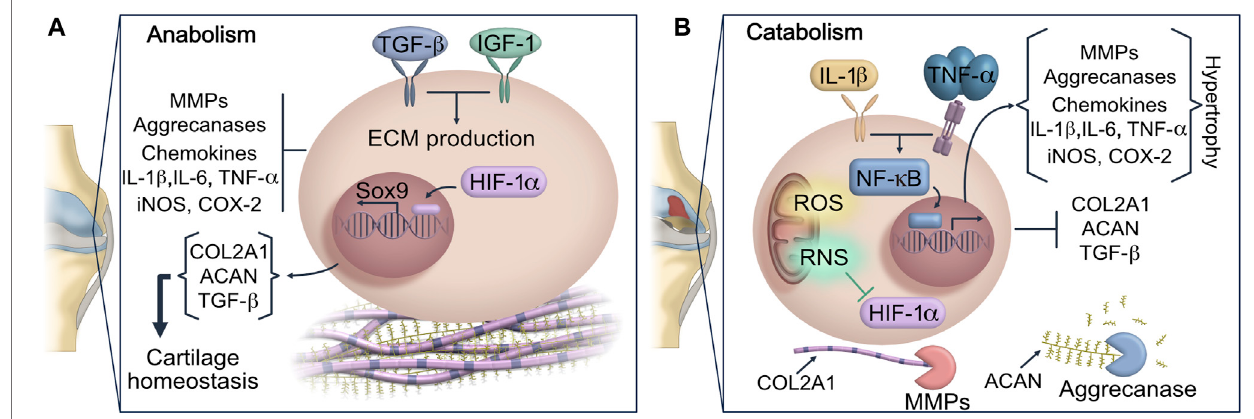
FIGURE 1 | Dysregulation of joint homeostasis in OA. (A) Anabolic metabolism regulates gene expression and protein synthesis of COL2A1 and ACAN in chondrocytes, maintaining components of AC in a low-turnover state. (B) This scheme represents the homeostatic disruption of AC promoted by oxidative stress and pro-in fl ammatory cytokines. IL-1 and TNF- α signaling trigger the upregulation of MMPs and ADAMTS. Then the exacerbated release of MMP-13 prompts COL2A1 and ACAN hydrolysis, which are considered key components of AC matrix. The matrix degradation is intensi fi ed by the activity of ADAMTS, resulting in the loss of cartilage integrity and additional loss of joint function. In fl ammation, ROS and RNS not only stimulate the expression of ECM degradative enzymes, but they also impair the chondrocyte ability to repair damaged cartilage by blocking HIF-1 α and SOX9 signaling. AC: articular cartilage; ACAN: aggrecan; ADAMTS: a disintegrin and metalloproteinasewiththrombospondinmotif;COL2A1:typeIIcollagen;ECM:extracellularmatrix;HIF-1 α :hypoxia-induciblefactor1alpha;MMPs:metalloproteinases; ROS: reactive oxygen species; RNS: reactive nitrogen